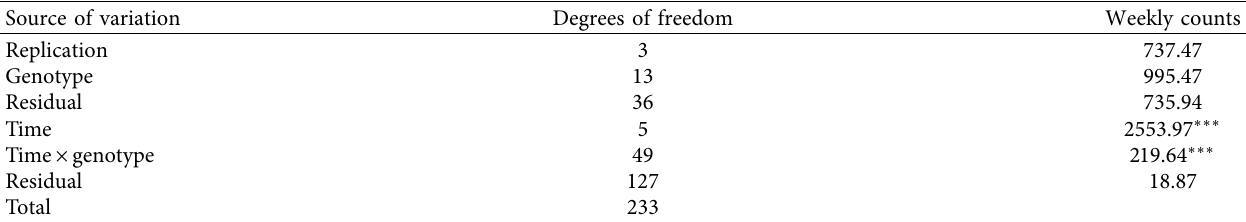
Table 6: Analysis of variance for Striga counts recorded from 42 nd day after planting (DAP) to 72 nd DAP.